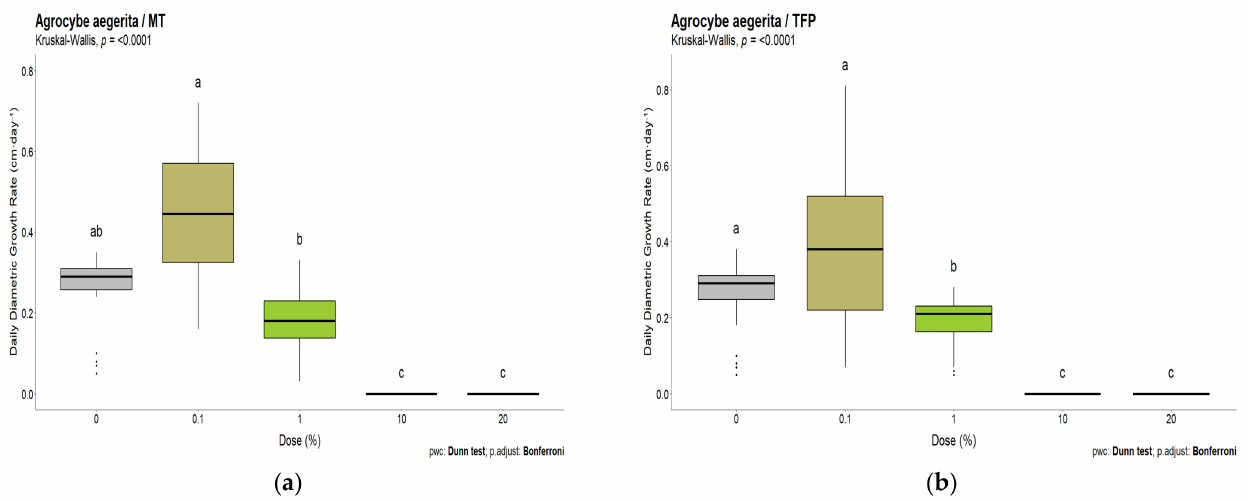
Figure 7. Daily growth rate for A. aegerita at different concentrations of ( a ) mimosa tannin (17 days) and ( b ) tannin–furanic polymer (20